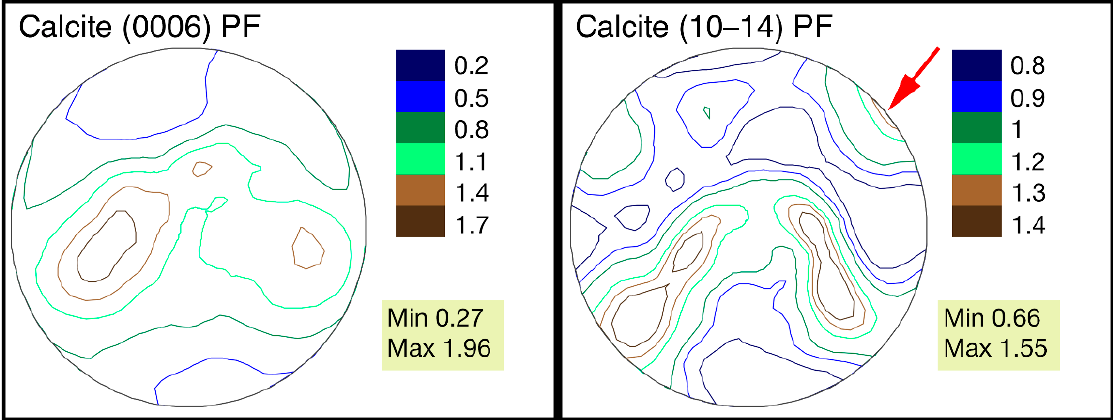
Figure 5. Calcite pole figures for the left valve of Gryphaea dilatata Sowerby, 1816, with a friable white surface layer, Oryol region, Kromy district, sand quarry near the village of Sukhochevo. The red arrow shows the area of anomalous sharpness maxima.